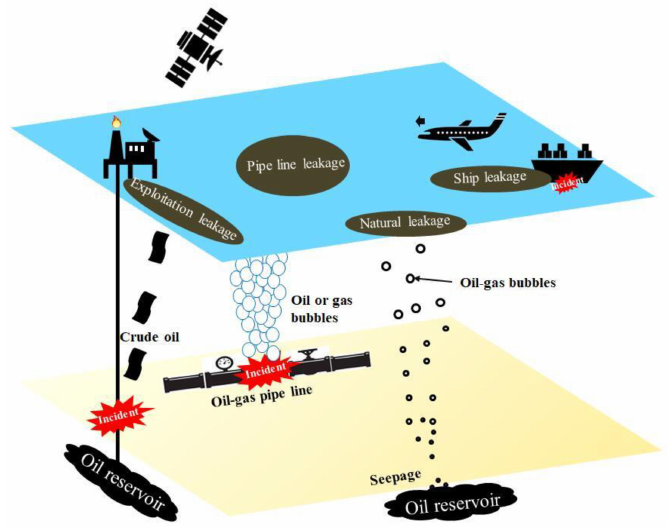
Figure 1. Schematic diagram of the marine oil-gas